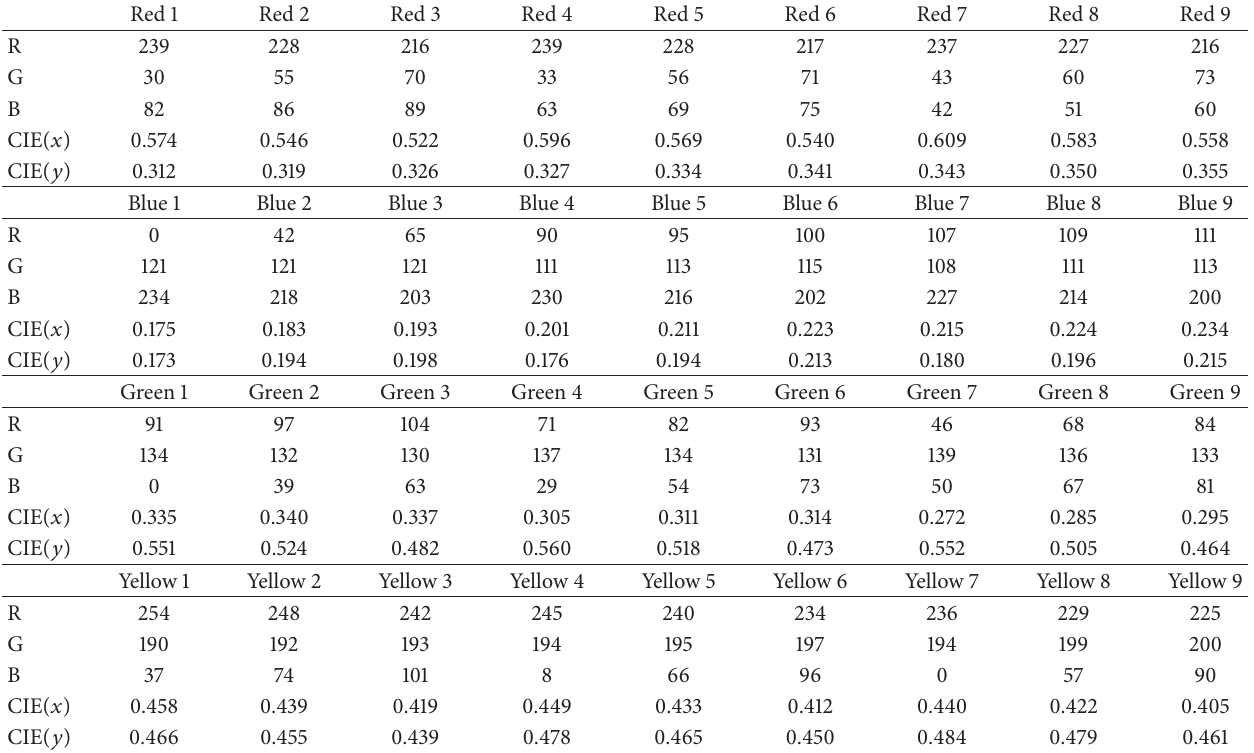
Color definitions for the 36 hues used for the search and memory task. RGB (red, green, and blue) values and CIE( 𝑥,𝑦 ) values, measured with the HCFR Monitor Calibration Software (http://sourceforge.net/projects/hcfr/) using an 𝑥 -rite i1 DisplayPro colorimeter, are